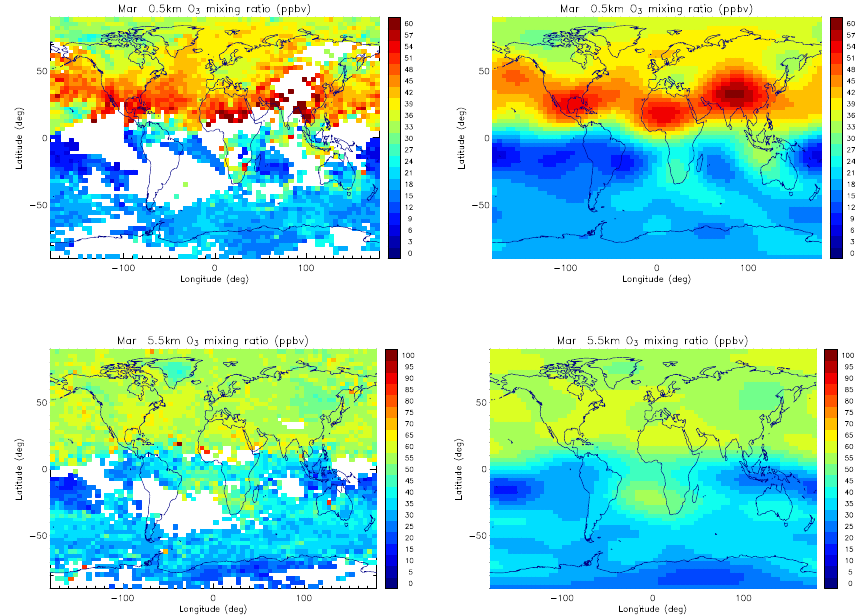
Figure 5: Ozone maps at 0.5 km altitude above the surface and 5.5 km above sea level. Fig. 5. Ozone maps at 0.5km altitude above the surface and 5.5km above sea level. Left-hand side: mapping; right-hand side: after smoothing Left-hand side: mapping; Right-hand side: after smoothing and interpolation. Data from 1980-2008 and interpolation. Data from 1980 to 2008 are are used.